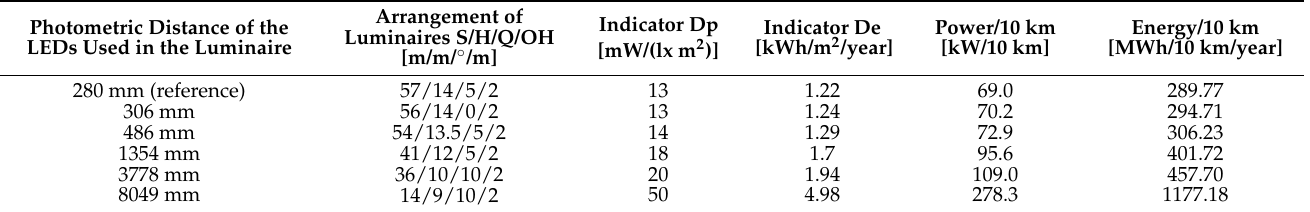
Table 7. The analysis of the effect of the photometric distance of single LEDs on the results of lighting installation projects.